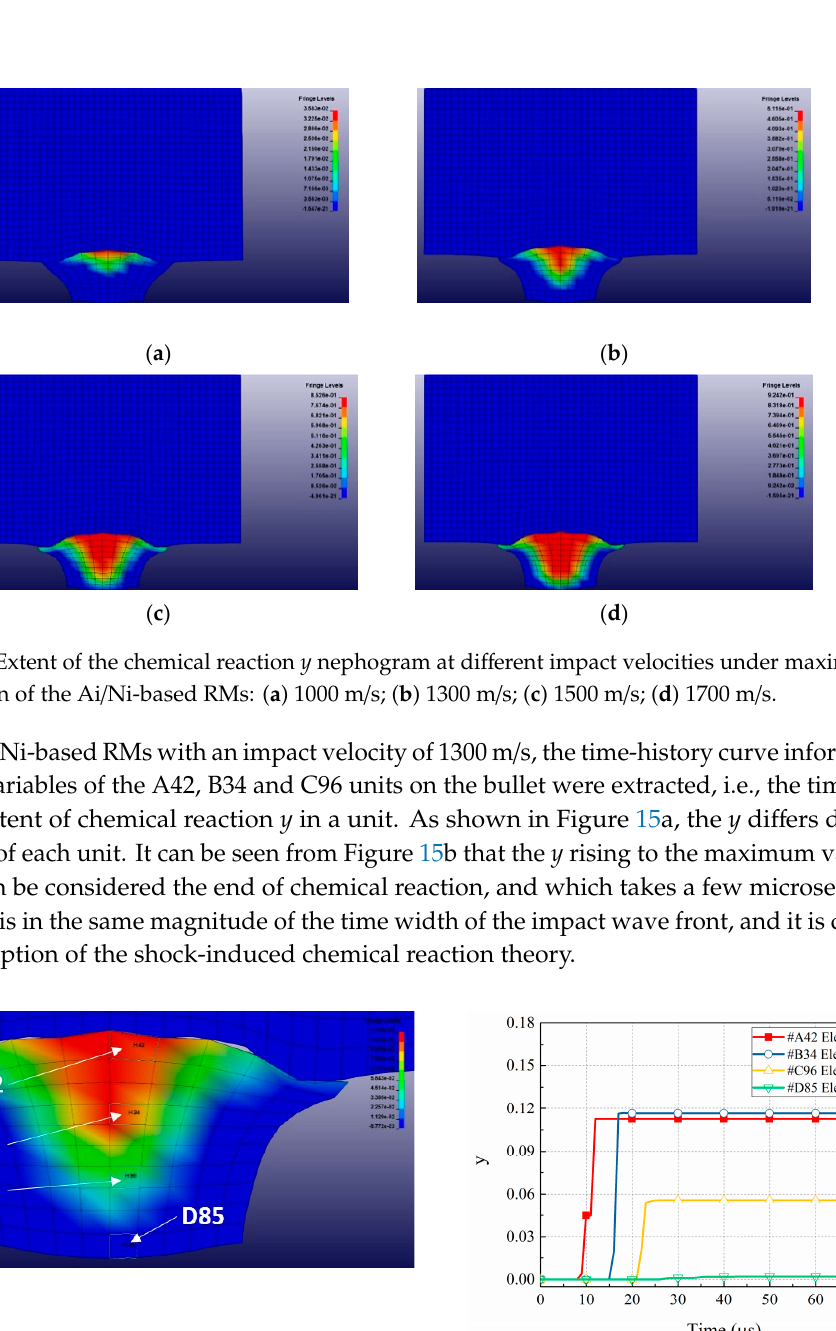
 Table 11. Parameters of the thermal constitutive model [46]. Materials